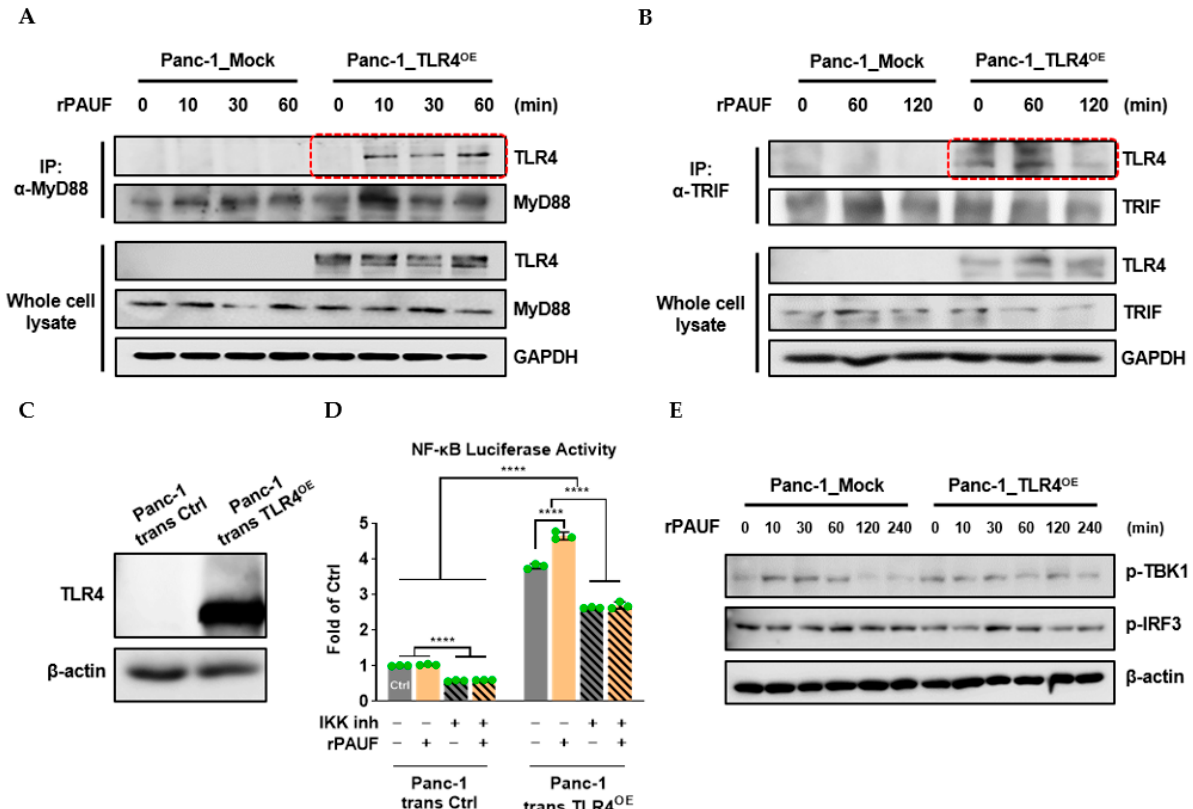
Figure 6. PAUF activates the MyD88-dependent, not the TRIF-dependent, TLR4 downstream pathway. ( A ) Panc-1_Mock and Panc-1_TLR4 OE cells were treated with rPAUF (0.1 µg/mL) for 0, 10, 30, and 60 min. Collected proteins were immunoprecipitated with MyD88 antibody ( α -MyD88) using protein A agarose beads. Immunocomplexes were determined by Western blot against MyD88 and TLR4. ( B ) Panc-1_Mock and Panc-1_TLR4 OE cells were treated with rPAUF (0.1 µg/mL) for 0, 60, and 120 min. Collected proteins were immunoprecipitated with TRIF antibody ( α -TRIF) using protein A agarose beads. Immunocomplexes were determined by Western blot against TRIF and TLR4. ( C ) Western blot showed that Panc-1_trans TLR4 OE cells were successfully engineered to transiently overexpress TLR4, compared to the control, Panc-1_trans Ctrl cells. ( D ) Panc-1_trans Ctrl and Panc- 1_trans TLR4 OE cells were pretreated with or without IKK inhibitor XII (5 µM) for 4 h before rPAUF (0.1 µ g/mL) or PBS treatment. After overnight culture, cells were collected for dual-luciferase activity assay. Data are represented as a mean ± SD from triplicates (**** p < 0.0001 were obtained from two-way ANOVA and post-hoc multiple comparisons with Bonferroni correction). ( E ) Panc-1_Mock and Panc-1_TLR4 OE cells were treated with rPAUF (0.1 µ g/mL) for 0, 10, 30, 60, 120, and 240